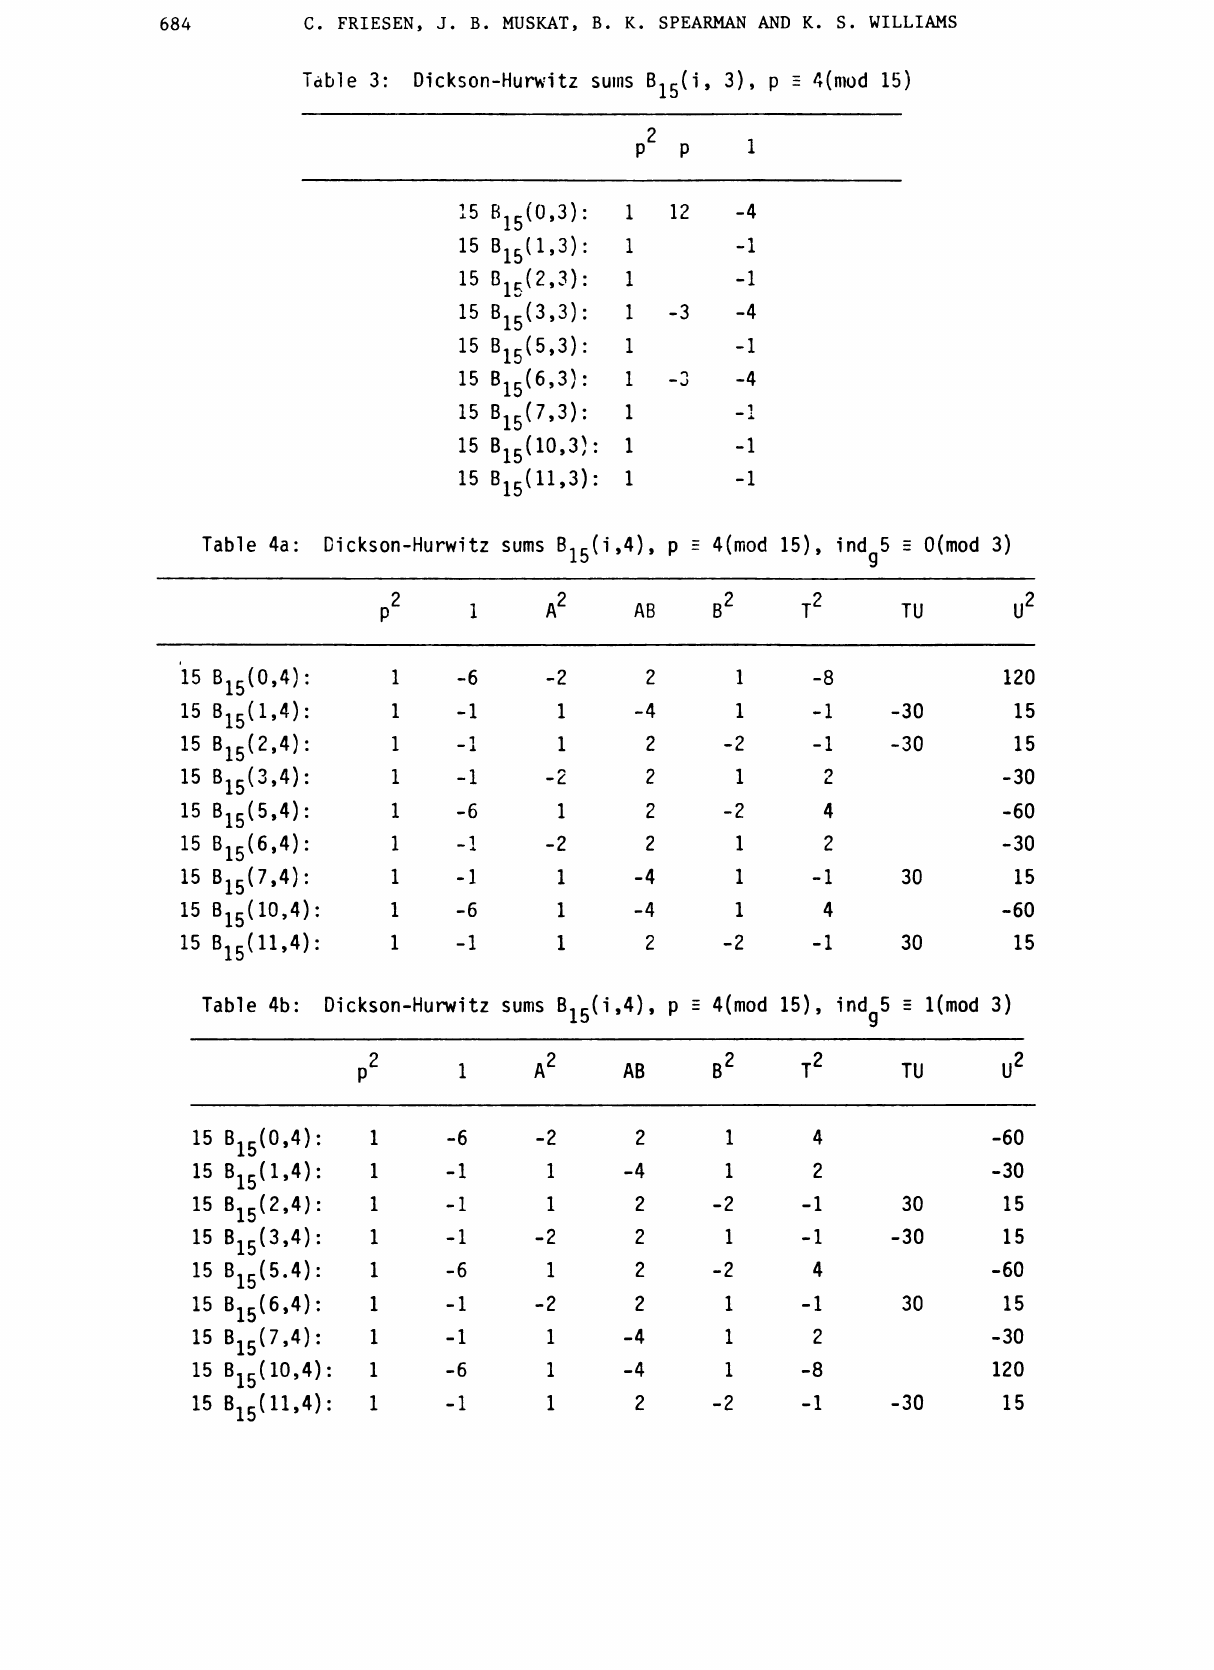
Dickson-Hurwitz sums B15(i, 3),